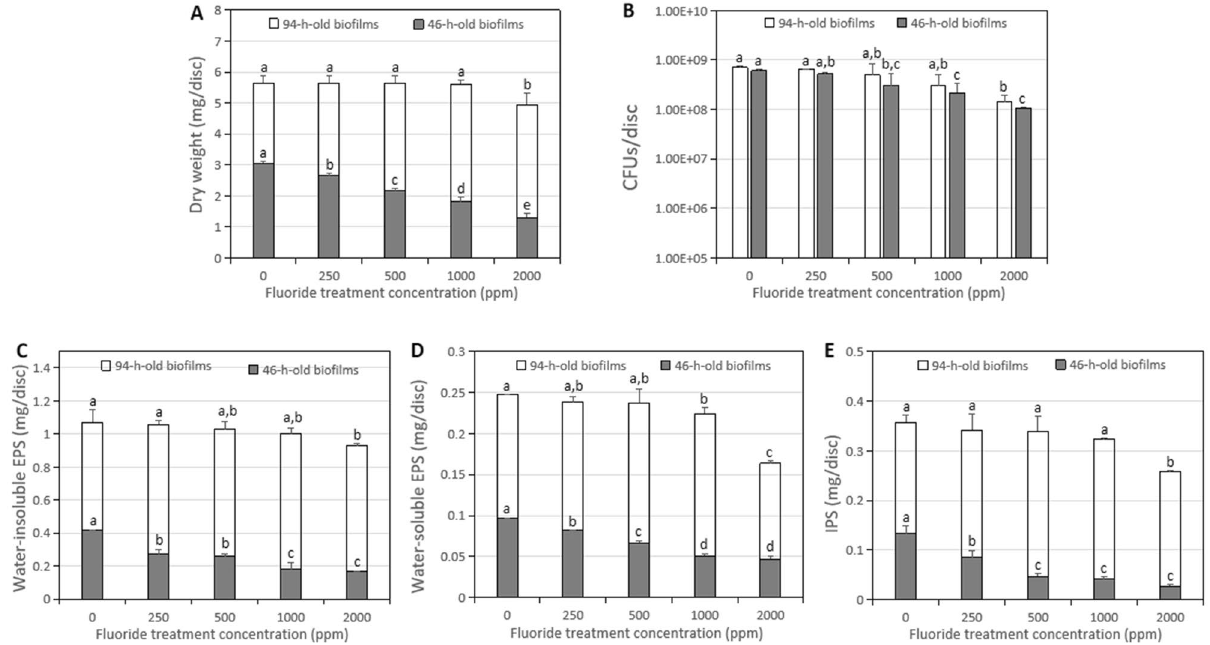
Figure 1. Change in the microbiological and biochemical composition of the 46/94-h-old S. mutans biofilms treated with different concentrations of fluoride. ( A ) Dry weight. ( B ) CFUs. ( C ) Water-insoluble EPSs. ( D ) Water-soluble EPSs. ( E ) Intracellular polysaccharides (IPS). Data represent mean ± standard deviation. In the 46-h-old S. mutans biofilms, ( A – E ), p < 0.05. In the 94-h-old S. mutans biofilms, figure ( A – C ), p > 0.05; ( D , E ), p < 0.05. * p < 0.05: significantly different from each other. p > 0.05: values followed by the same superscript are not significantly different from each